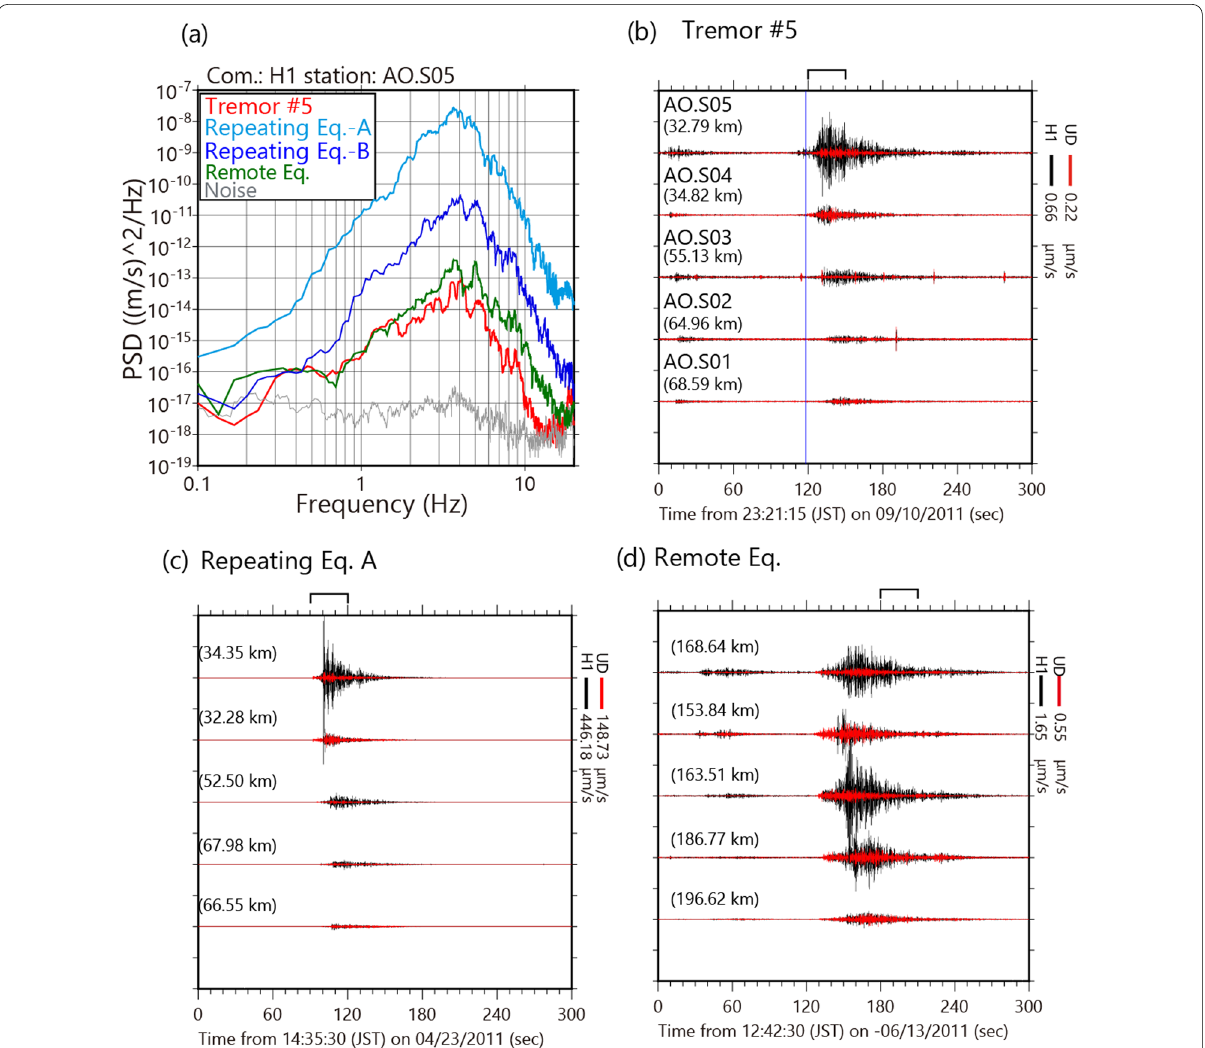
Fig. 2 Characteristics of tremors observed by the ocean-bottom seismometers (OBSs) a Power spectra of the tremor, the repeating earthquakes, and the remote earthquake shown in Fig. 1. Horizontal records at AO.S05 in the time window indicated by brackets in b are used. Background noise is taken from a window of 30 min before the origin time of known very low-frequency earthquake (VLFE) #5. (b) Filtered (2–4 Hz) seismograms during tremor #5, whose location is shown as a green circle in the left top inset of Fig. 1. Vertical and horizontal records are shown by red and black traces, respectively. Epicentral distances are shown in parentheses. The vertical blue line shows the origin time of the VLFE #5. c Filtered (2–4 Hz) seismograms during repeating earthquake-A, d Filtered (2–4 Hz) seismograms during a remote earthquake